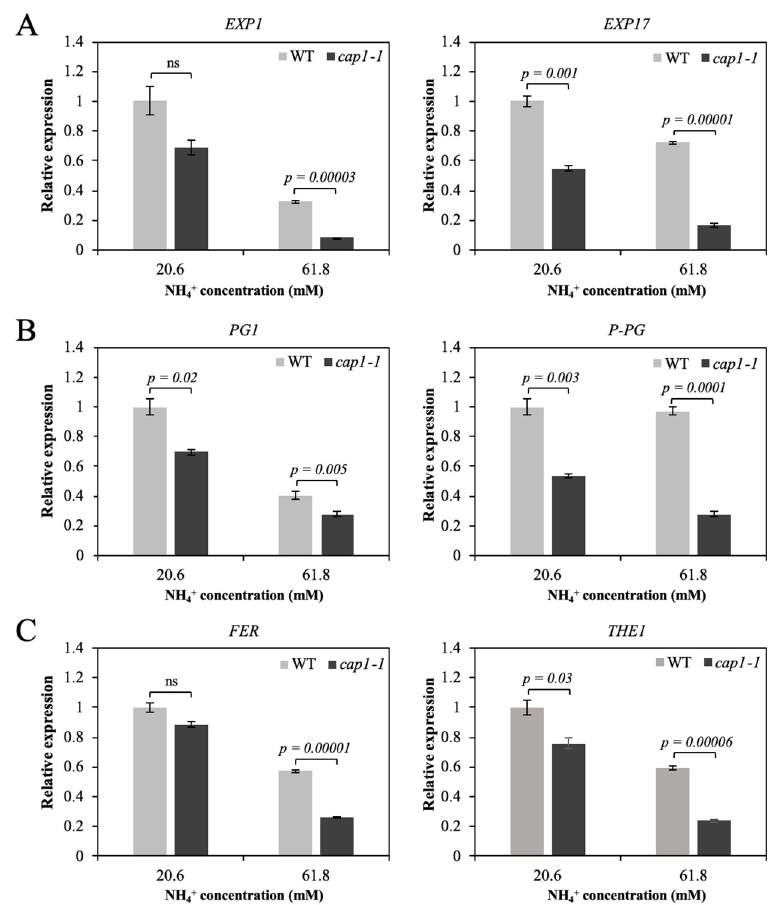
Figure 3. The expression of cell expansion-related genes in WT and cap1-1 plants. Seven-day-old seedlings were transplanted to a pot containing only vermiculite with MS medium (20.6 mM NH 4 + ) or MS medium with high content of ammonium (61.8 mM NH 4+ ) and grew for about 4 weeks, and then 3rd leaf of WT and cap1-1 plants were harvested. ( A ) Relative transcript levels for EXP1 and EXP17 , ( B ) PG1 and P-PG , and ( C ) THE1 and FER in WT and cap1-1 plants are determined by qRT-PCR. The value for each gene in the WT at MS medium (20.6 mM NH 4+ ) was set as 1. Data are presented as means ± SE of three replicates (independent samples t -test; p < 0.05; ns, not